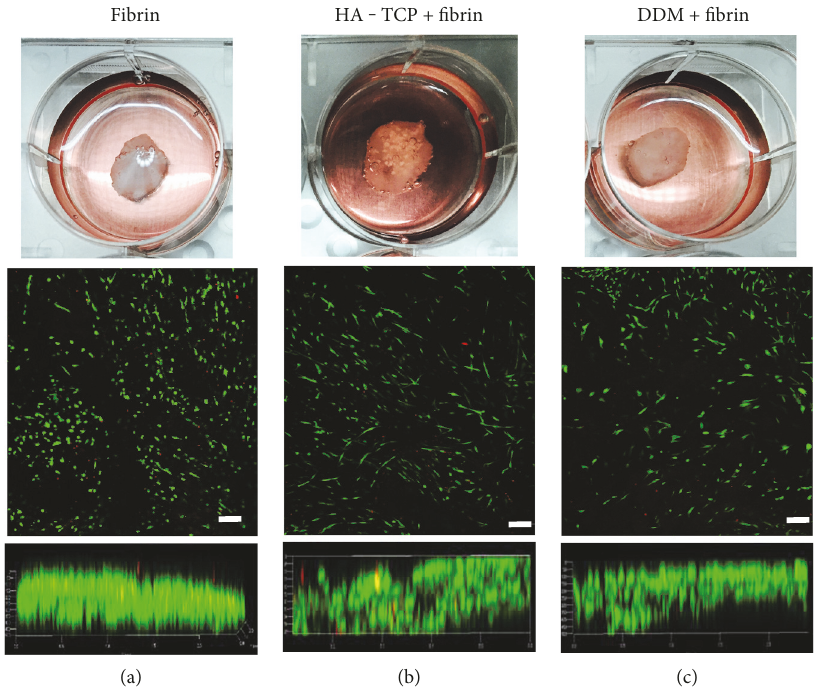
Figure 3: Cell viability of hDPSCs cultured in fi brin gel block. Cells were encapsulated with HA-TCP and DDM in fi brin and cultured in media for 4 days. Fibrin gen blocks were built at a certain size (upper panels). Scale bars: 1cm. Cell viability was analyzed by using the live-dead viability assay kit. Live and dead cells were stained as green and red, respectively. Cells were detected on the surface of the block (middle panels) and in the interior of the blocks as a cross-sectional view of the block (lower panels). (a) Fibrin gel with hDPSCs. (b) HA- TCP/ fi brin gel with hDPSCs. (c) DDM/ fi brin gel with hDPSCs. Scale bar: 200 μ